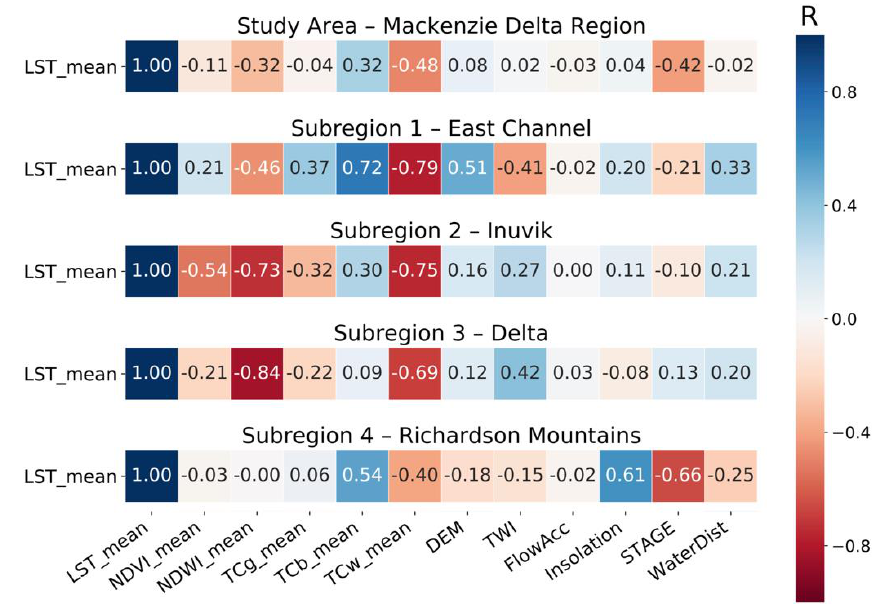
Figure 5. Subsets of the correlation analyses as linear Pearson Correlation Coe ffi cients ( R ) for the entire study area, and the subplots “East Channel”, “Inuvik”, “Delta”, “Richardson Mountains”. A tabular summary of all investigated parameters and their abbreviations is provided in Appendix B (Table